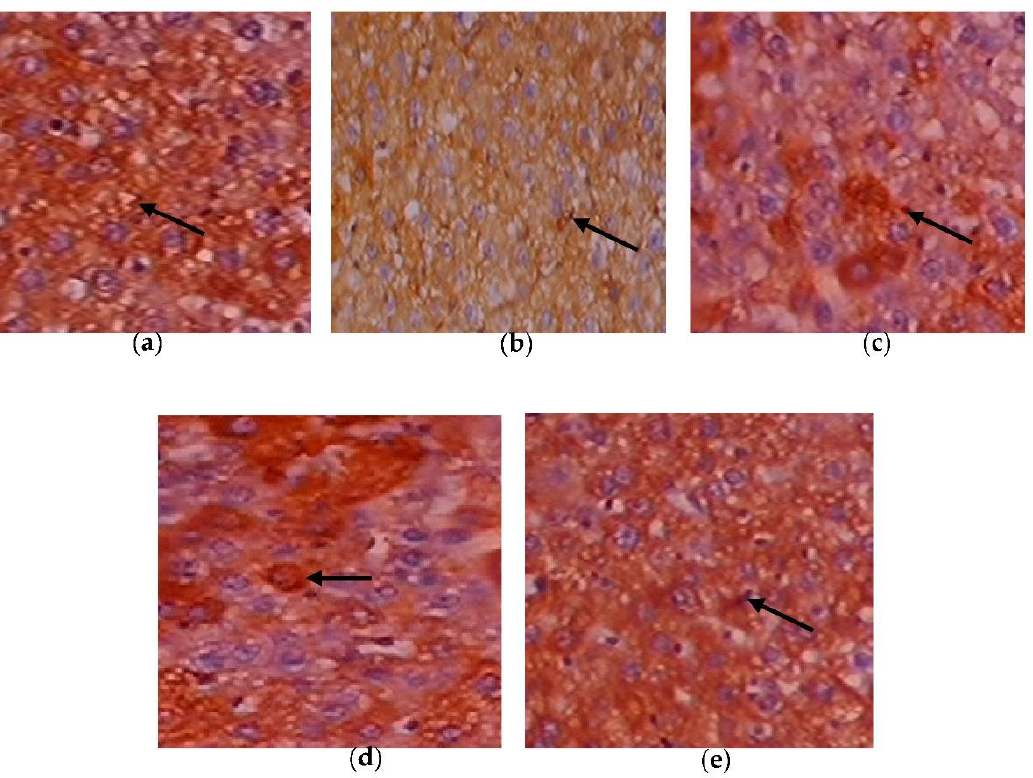
Figure 11. Expression of GLUT-2 via immunohistochemistry (100×). ( a ) Control rats; ( b ) T2DM rats; ( c ) C. papaya -treated T2DM rats; ( d ) metformin-treated T2DM rats; ( e ) C. papaya -treated control rats.